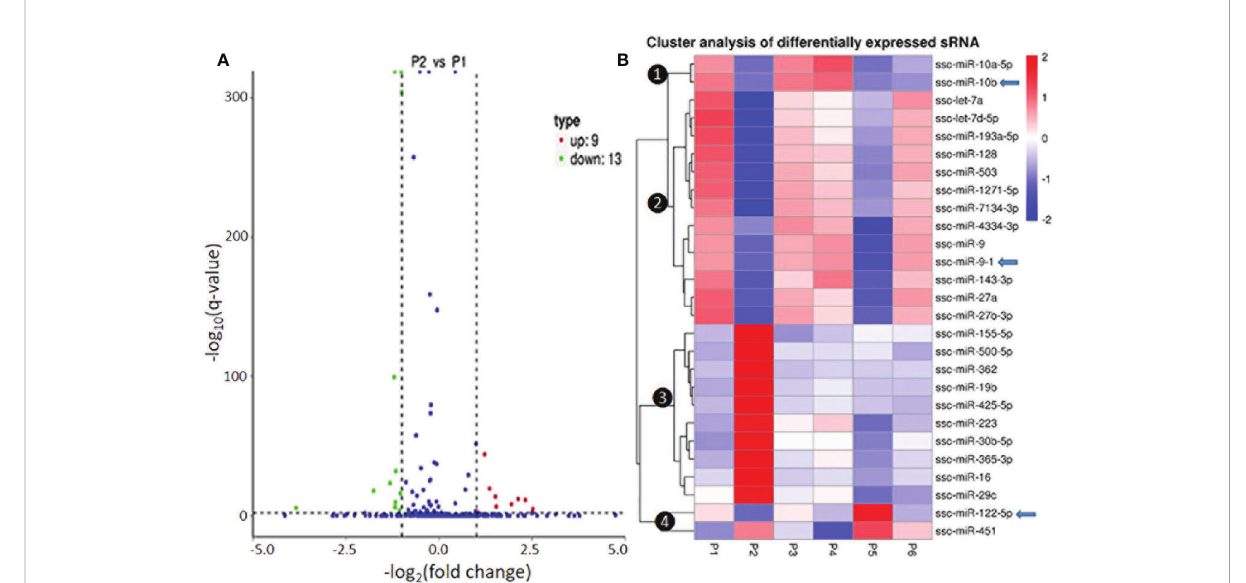
FIGURE 3 Differential expression and cluster analysis of differentially expressed miRNA (SEM) in different samples. (A) Volcano Plot to show DEMs in P2 (MLV) compared with P1 (Control). The other pairs of comparison are listed in Figure S7. The X-axis shows the fold change in miRNA expression between the different samples, and the Y-axis shows the statistical signi fi cance of the difference. Statistically signi fi cant differences (|log2 (FoldChange)| > 1 and q-value < 0.01) are represented by red or green dots for up- or down-regulated miRNA, respectively. (B) Hierarchical clustering of signi fi cantly DEMs (exempli fi ed of 157 families in total, see Supplemental Data Sheet for detail) in compared samples. miRNAs within the same cluster have the same trend in expression levels under different conditions. In addition to the TPM cluster, K-means and SOM were also used to cluster the log2(ratios) (data not shown). Arrows indicate miRNA that show differential expression and were selected for functional